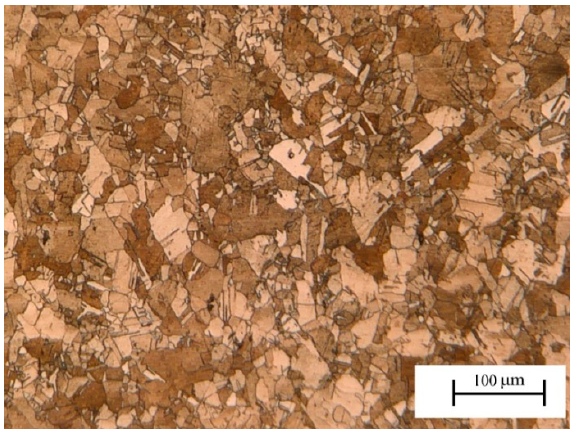
Figure 1. Optical micrograph of the microstructure of C1100 in the original state.